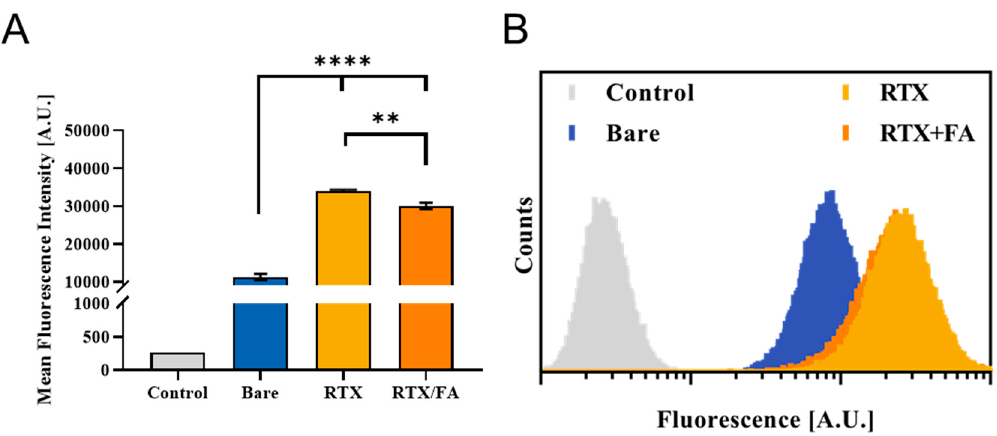
Figure 3. Cellular uptake of RTX and RTX / FA NPs in vitro via flow cytometry. ( A ) Mean fluorescence intensities of cell populations analyzed using flow cytometry show that the addition of the therapeutic alone and in combination with FA lead to higher uptake. **, p < 0.01, ****, p < 0.0001. ( B ) Representative histograms from each treatment group show marked shift in populations with the addition of the targeting layers. (RTX and RTX / FA are very similar in overall distribution, with most of the RTX distribution obscuring the view of the RTX / FA distribution.).